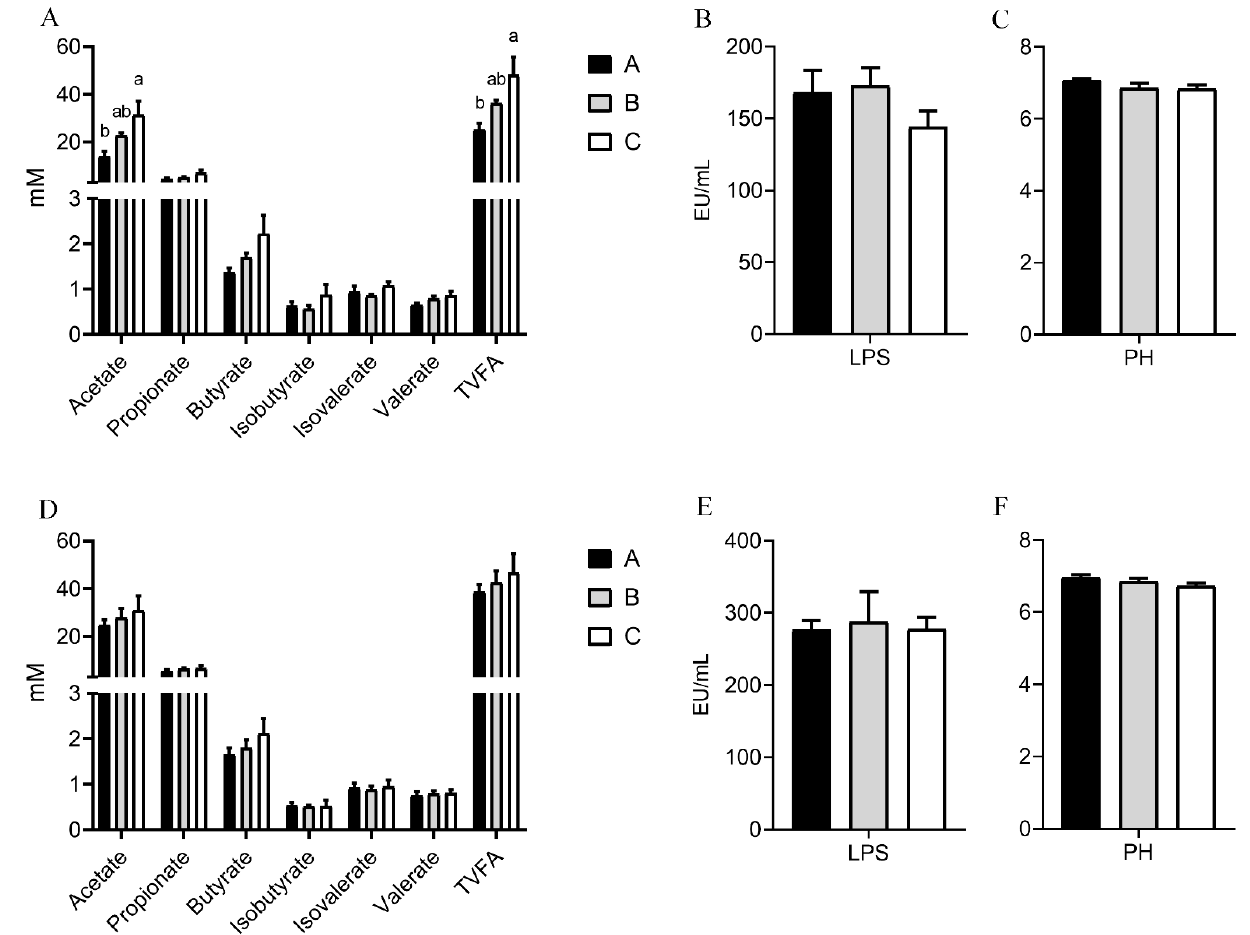
Figure 4. Effect of different nutrition levels on pH, VFAS, and LPS in the cecum ( A – C ) and colon ( D – F ). ( A ) Concentration of VFAs in cecum ( B ) Concentration of LPS in cecum ( C ) PH in cecum ( D ) Concentration of VFAs in colon ( E ) Concentration of LPS in colon ( F ) PH in colon. Different letters a, b represented significant differences between